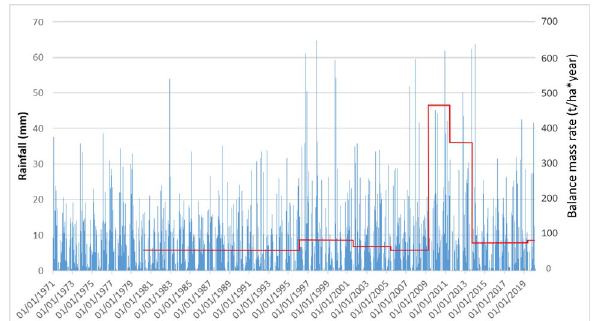
Figure 4. Daily rainfalls (mm) in the study area. In red, the mass rates of erosion